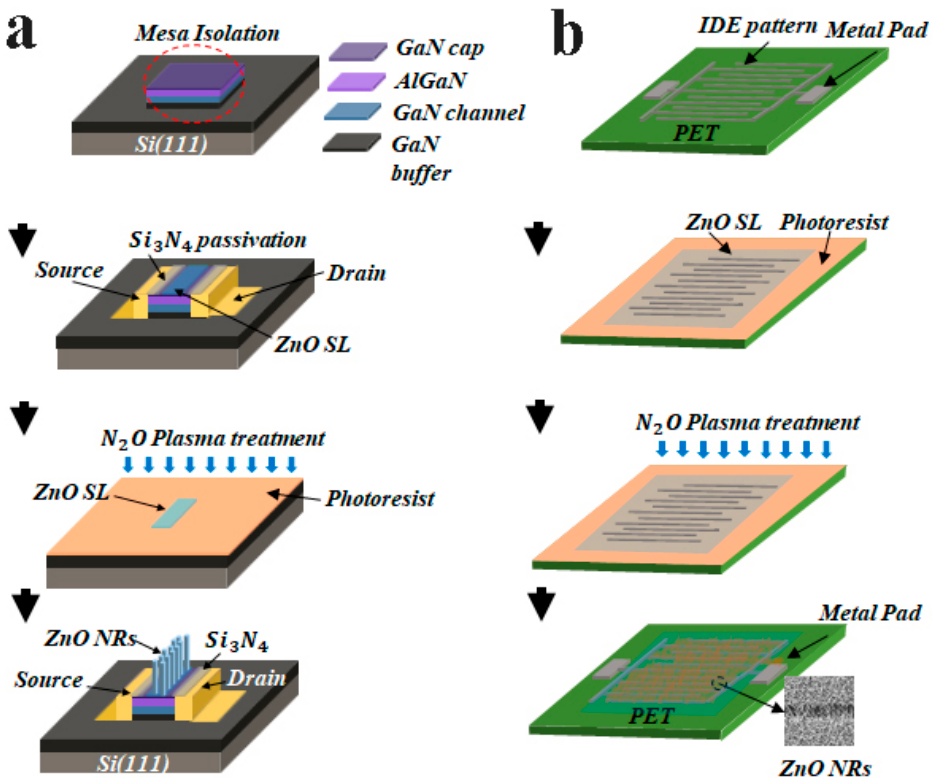
Figure 2. Schematic illustration of process flows for ( a ) HEMT-based and ( b ) IDE pattern-based PDs. A Keithley SMU (source meter unit) was used to measure I-V characteristics of the fabricated devices under both dark and UV illumination conditions. The spectral response of the PDs was measured by using a monochromatic light source with a wavelength range from 290–700 nm. A broad band Xenon lamp (200–1100 nm, 300 W) light was filtered and chopped into monochromatic light using a computer program controlled diffraction grating. Uniform monochromatic light was passed through a frequency chopper wheel at 30 Hz and illuminated on to the sample. The frequency of monochromatic light was fed to a lock-in amplifier, and the photocurrents from the devices were recorded at each wavelength (290–700 nm) and